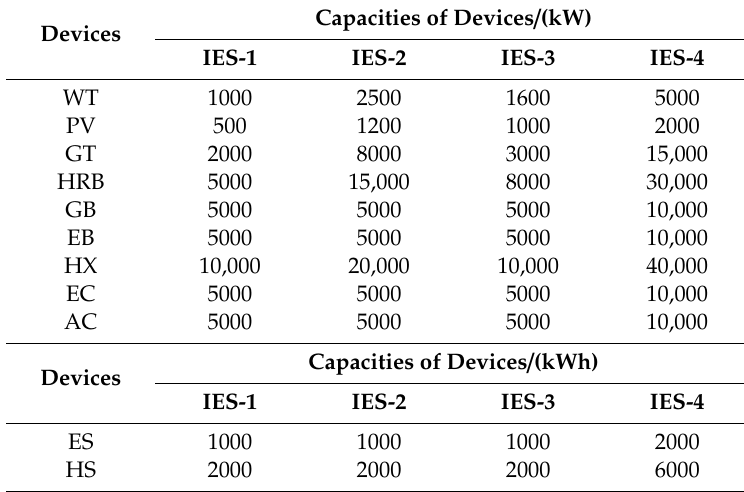
Table 3. Parameters of the heating network.